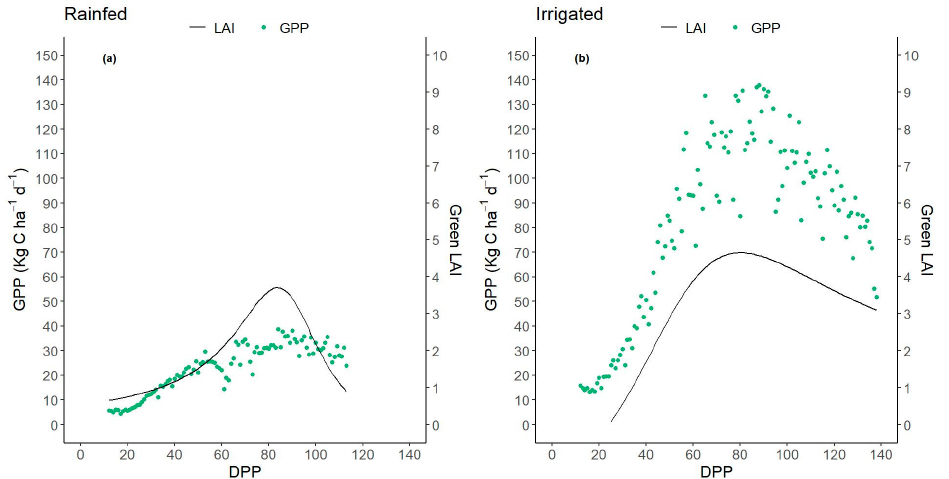
Figure 6. Gross primary productivity (GPP) and leaf area index (LAI) versus days post planting (DPP) in ( a ) Rainfed and ( b ) Irrigated potato crop.